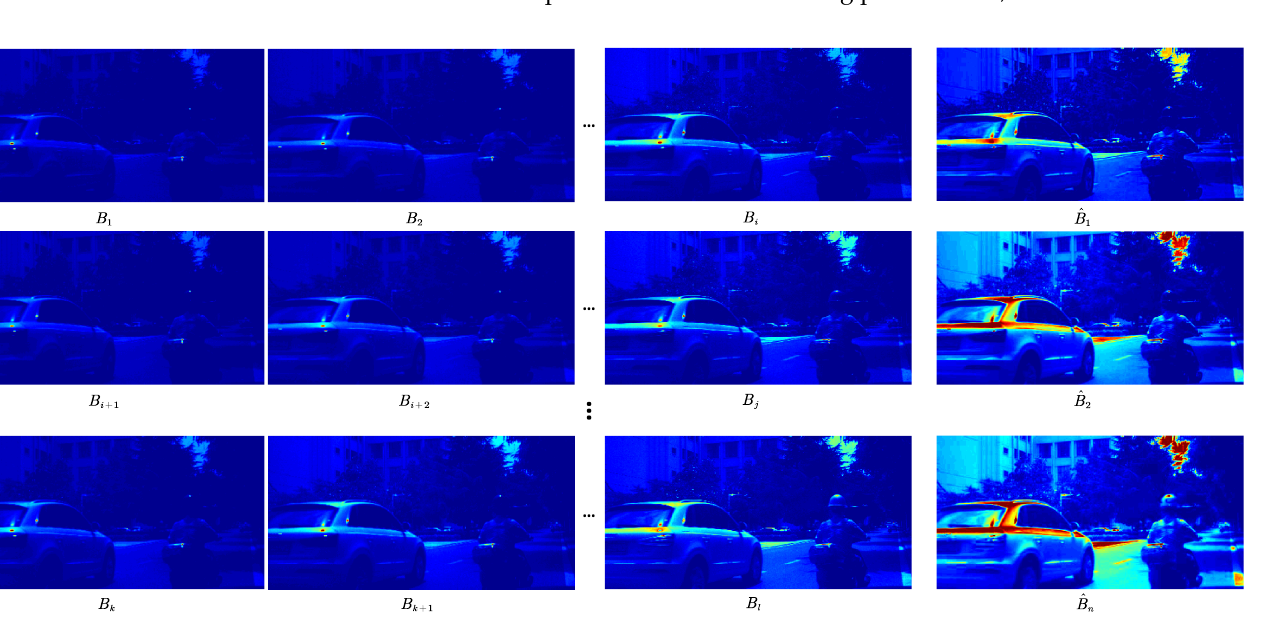
Figure 3. Visualization results of the spectral weighted fusion of the l